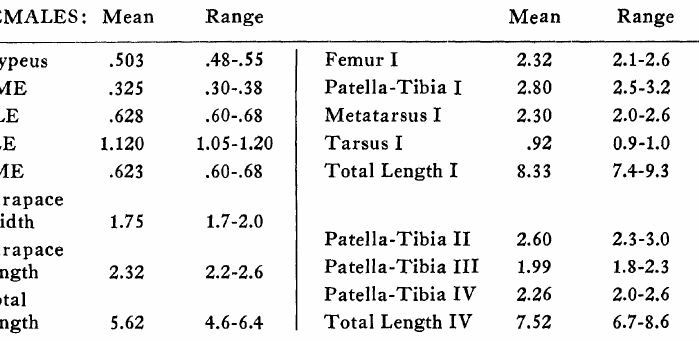
Figs. 13-14. Oxyoles flat, us Banks, female from Iquala, Guerrero, 27 Oct. 1947. 13. Face view. 14. Dorsal view. Figs. 15-16. Oxyoes lanther new species, female from Palos Colorados, Durango, Aug. 1947. 15. Face view. 16. Dorsal view. Figs. 17-18. Oxyoles ocelot new species, female from Areelia, Guerrero, 2 Nov. 1947. 17. Face view. 18. Dorsal view. Figs. 19-20. Oxyoes cornutus F.O.P.-Cambridge, female from 8 mi. SW of Colima, Colima, 10 May 1963. 19. Face view. 20. Dorsal view. Figs. 21-22. Oxyoles [elinus Brady, female from SW of Acapo.neta, Nayarit, 15 May 1963. 21. Face view. 22. Dorsal